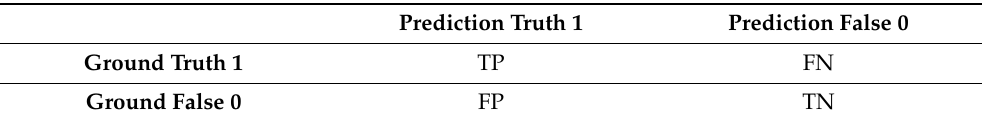
Table 1. Confusion matrix for binary classification [67], 1 represents landslide pixel, and 0 represents background